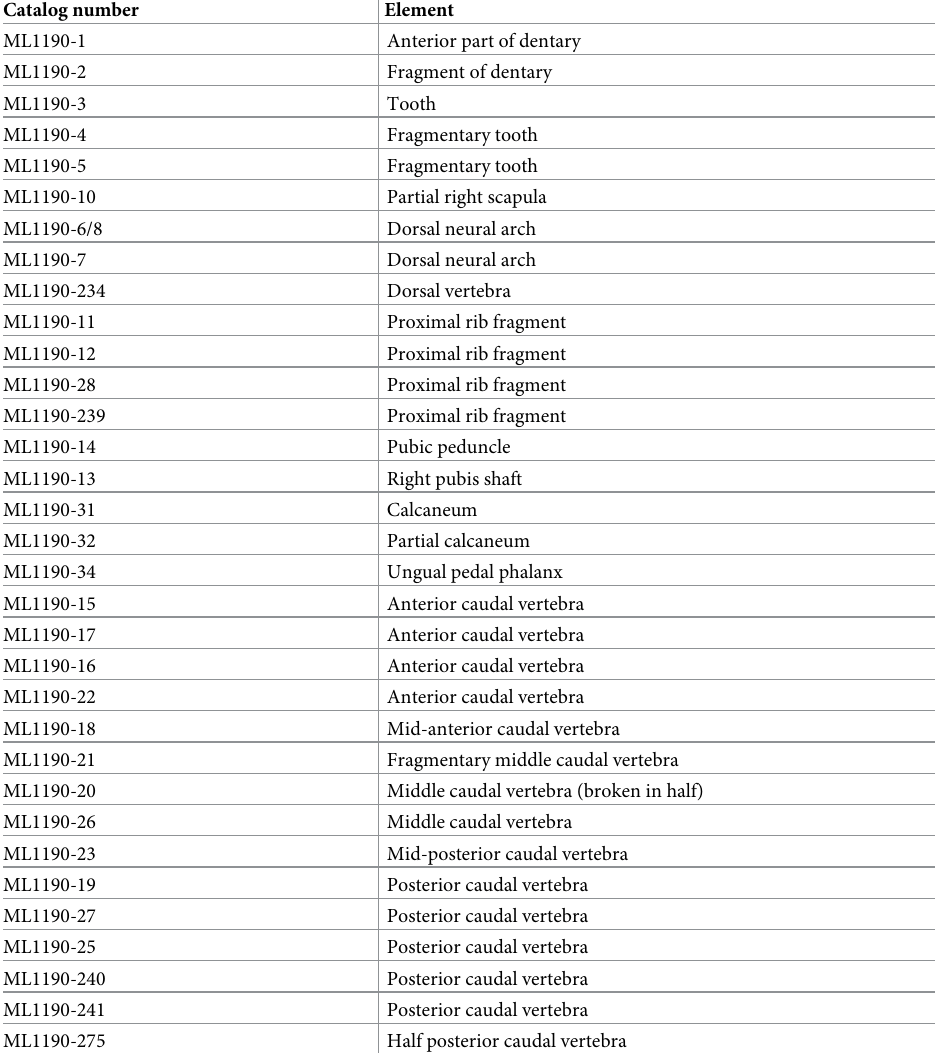
Table 1. Material recovered from the holotype of Iberospinus natarioi (ML1190). Catalog